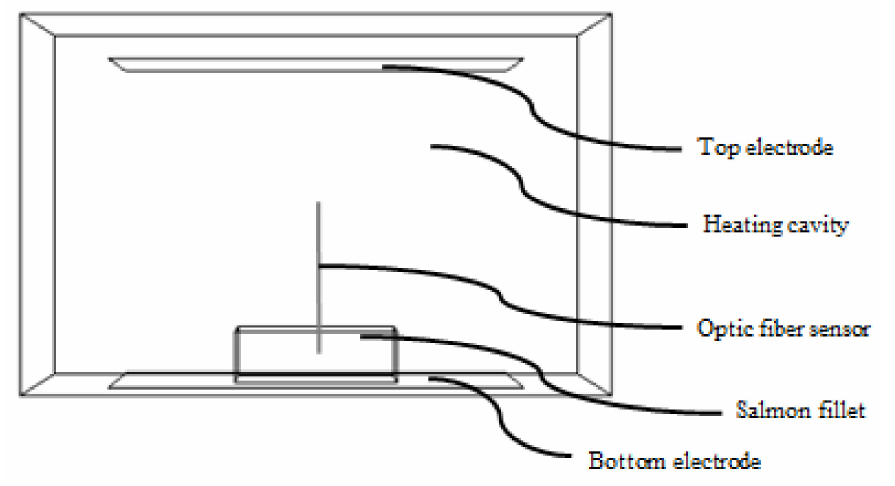
Figure 1. Layout of RF system and placement of salmon fillet sample and fiber optic